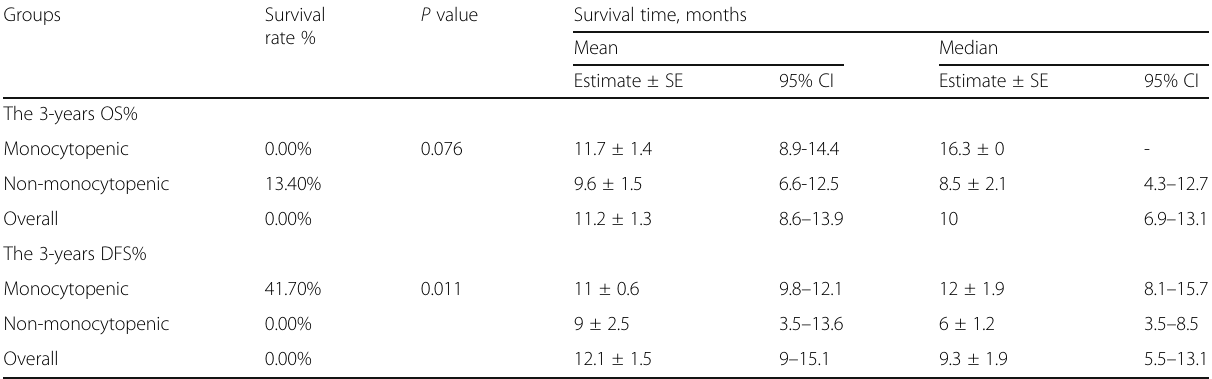
Table 4 The 3-year overall and Disease-free survival rates in both groups